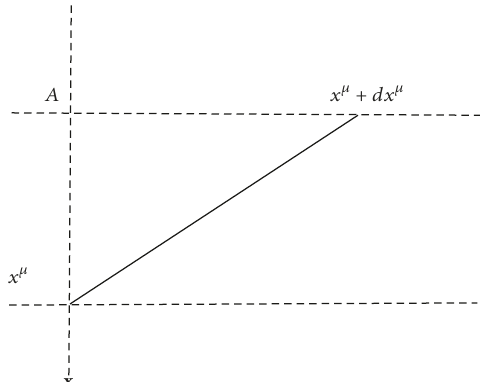
Figure 2: Time and distance between the events 𝑥 휇 and 𝑥 휇 + 𝑑𝑥 휇 . Equation (29) determines the event 𝐴 (at spatial point 𝑥 ) simultaneous with 𝑥 휇 + 𝑑𝑥 휇 . So the time interval between 𝑥 휇 and 𝑥 휇 +𝑑𝑥 휇 coincideswiththeintervalbetween 𝑥 휇 and 𝐴 andisgivenby (30). Distance between 𝑥 휇 and 𝑥 휇 + 𝑑𝑥 휇 coincides with the distance between 𝑥 휇 + 𝑑𝑥 휇 and 𝐴 ; the latter is given in